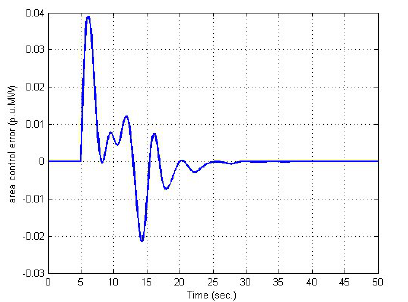
Fig. 10: ACE in control area 1 (Case 2)